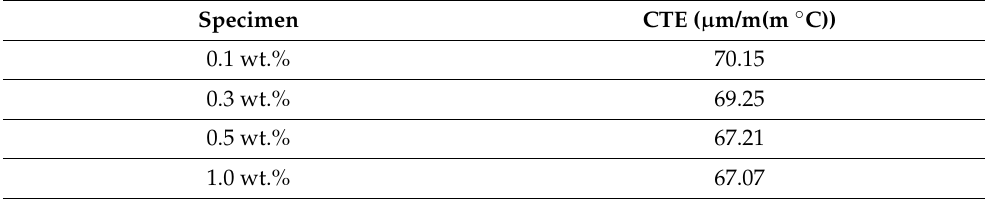
Table 5. Coefficient of linear expansion (CTE) of colored epoxy resin according to pigment concen-